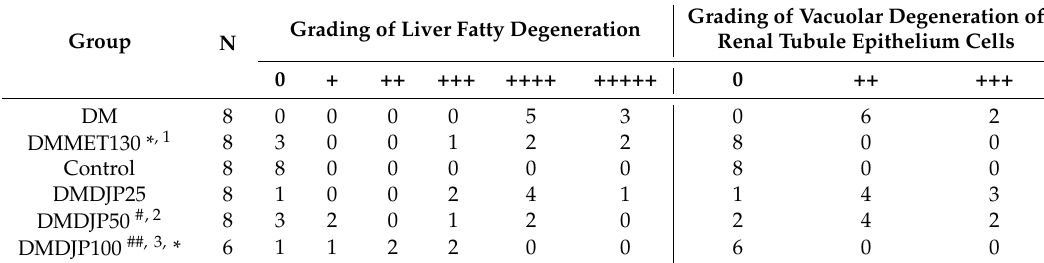
Table 2. Grading of liver fatty degeneration/vacuolar degeneration of renal tubule epithelium cells in the mice. Grading of Liver Fatty Degeneration Group N Grading of Vacuolar Degeneration of